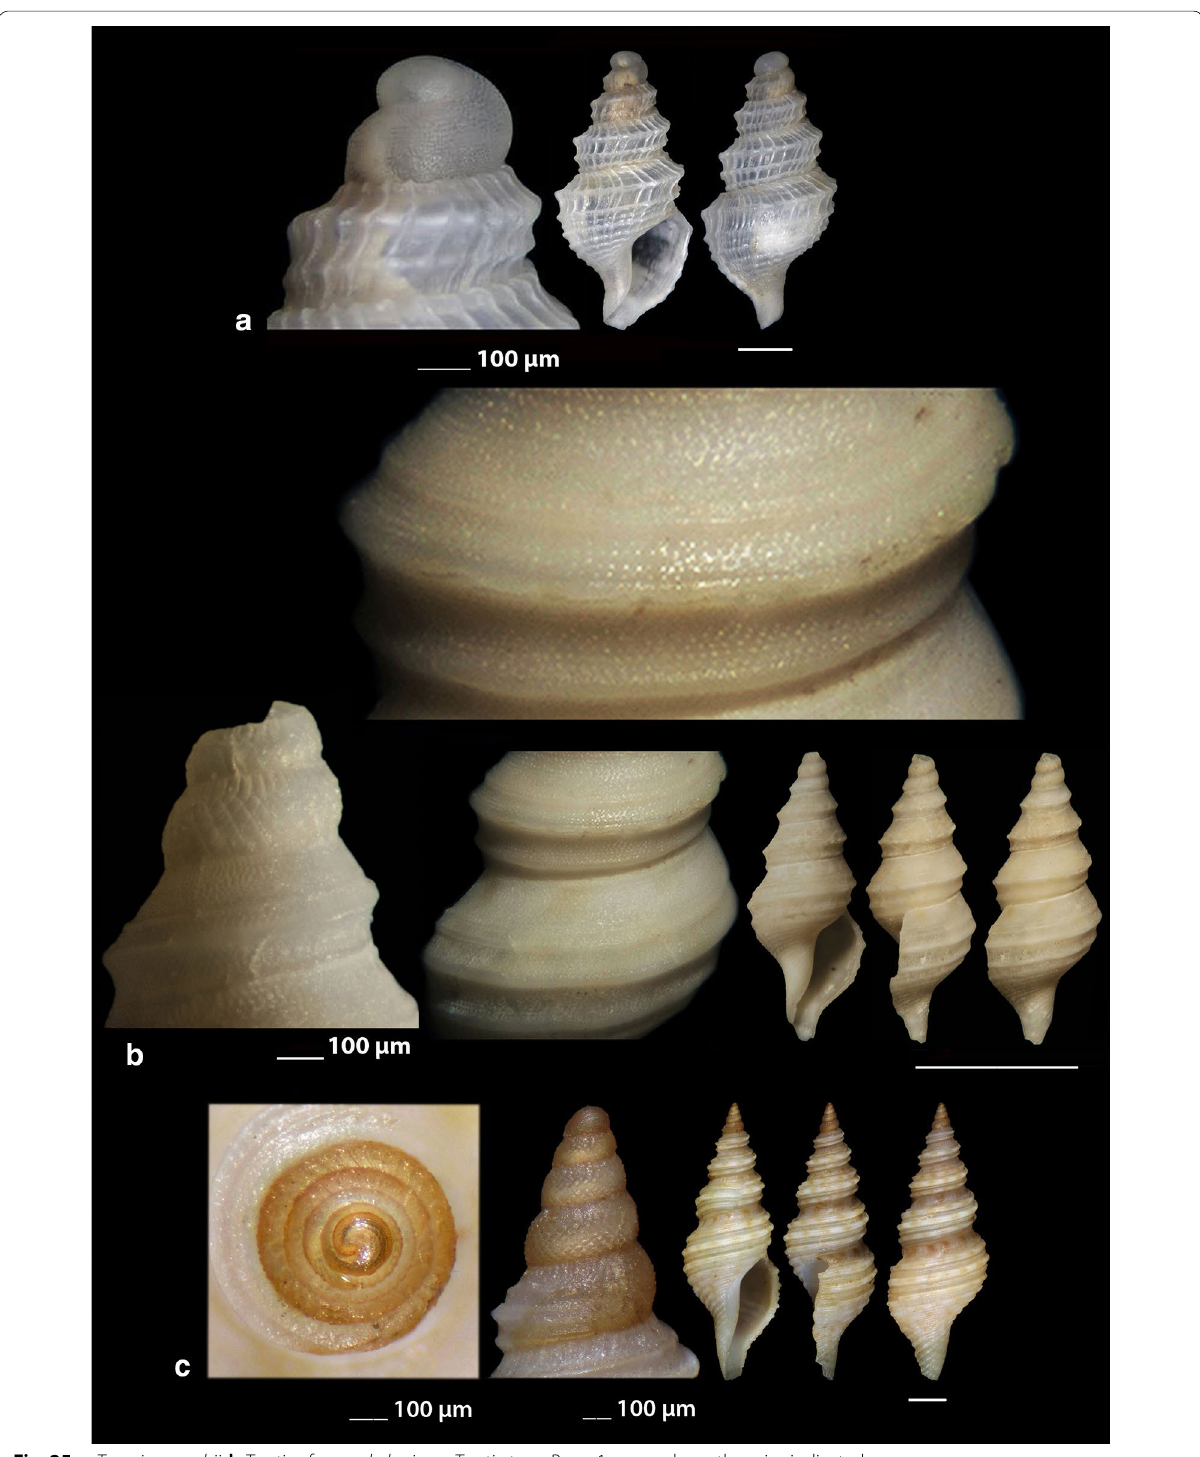
Fig. 25 a Taranis moerchii , b Teretia cf. neocaledonica , c Teretia teres . Bar